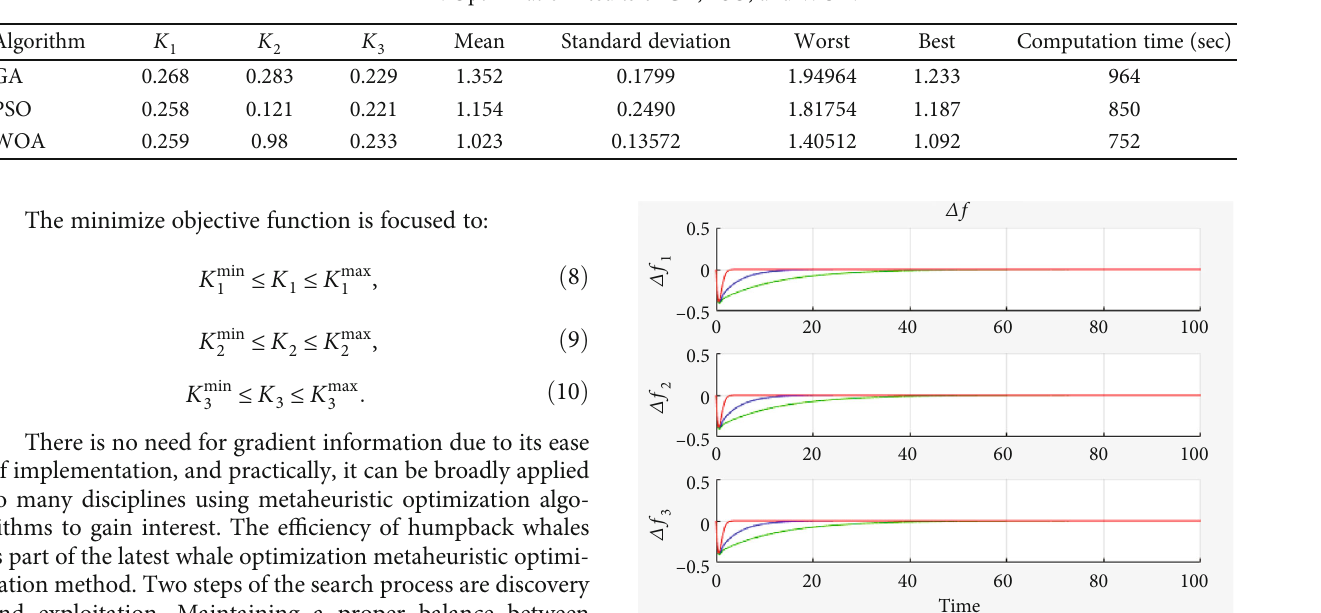
Table 2: Optimization results of GA, PSO, and WOA.